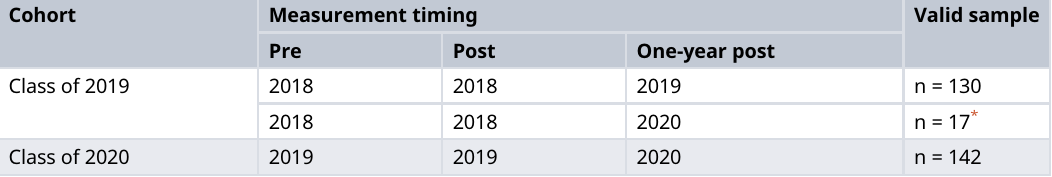
Table 2. Measurement timing for each cohort and valid sample